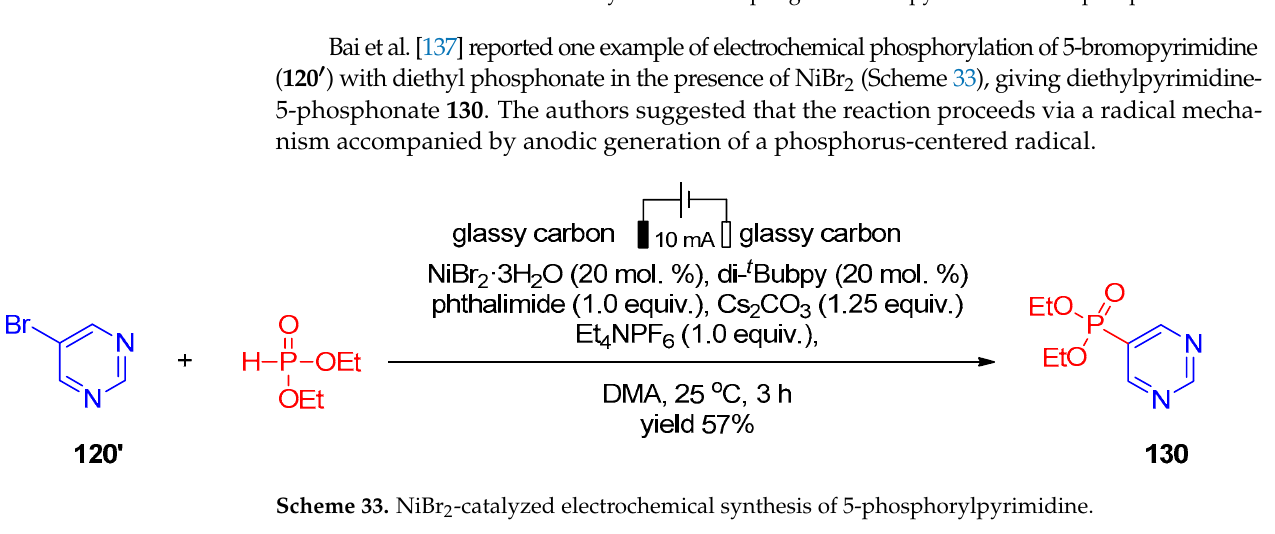
Figure 4. Approaches to synthesis of POR 2 -containing pyrazines. 5.1. Dimerization Reactions Palacios et al . [138] described synthesis of phosphorus-substituted pyrazines via dimerization of nitrile ylides 133 (Scheme 34), which can be generated in situ from POR 2 -bearing 2 Н -azirines 131 (pathway А ) or tosylated 2-hydroxyiminophosphonates 132 (pathway В ). According to the proposed mechanism, intermediate 133 undergoes self-dimerization to dihydropyrazine 134 followed by either oxidation of the latter com- pound or elimination of secondary phosphine oxide. An interesting feature of this transformation is that it allows targeted synthesis of either mono- or bisphospho- rus(V)-substituted pyrazines 135 and 136 . Thus, synthesis via pathway А at 80 ° С affords products 136 , whereas heating to 110 ° С yields products 135 . The outcome of the reaction via pathway B is determined by substituents on the phosphorus(V) moiety. Thus, pres-